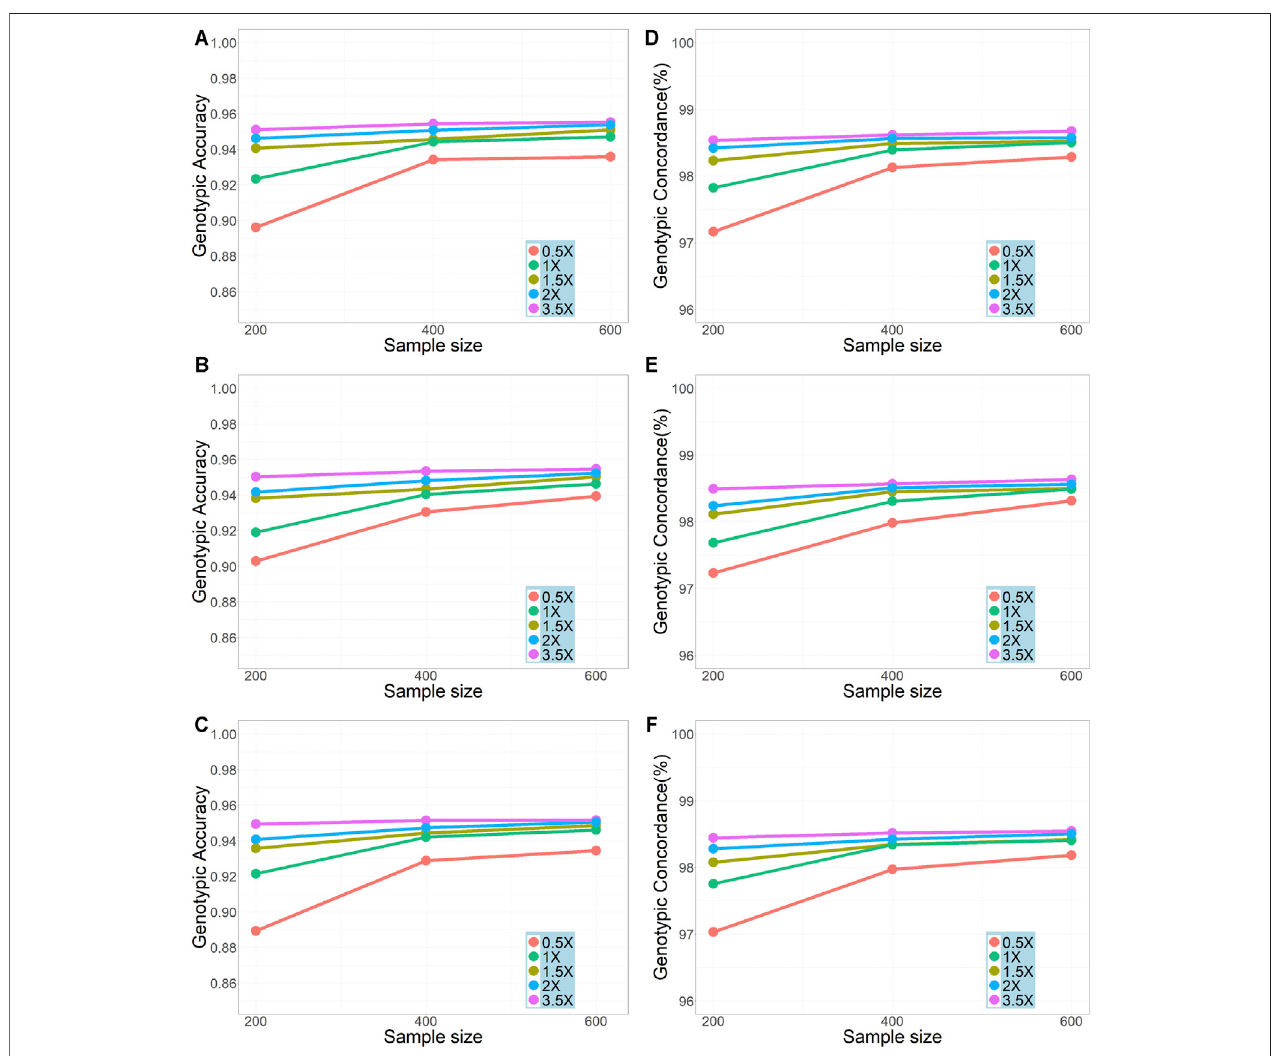
FIGURE 2 | Effects of sample size and sequencing depth on imputation genotypic accuracy and genotypic concordance using the pipeline of BaseVar + STITCH. (A – C) representgenotypeaccuracyforchromosomes1,19,and30,respectively; (D – F) representgenotypeconcordanceforchromosomes1,19,and30,respectively.